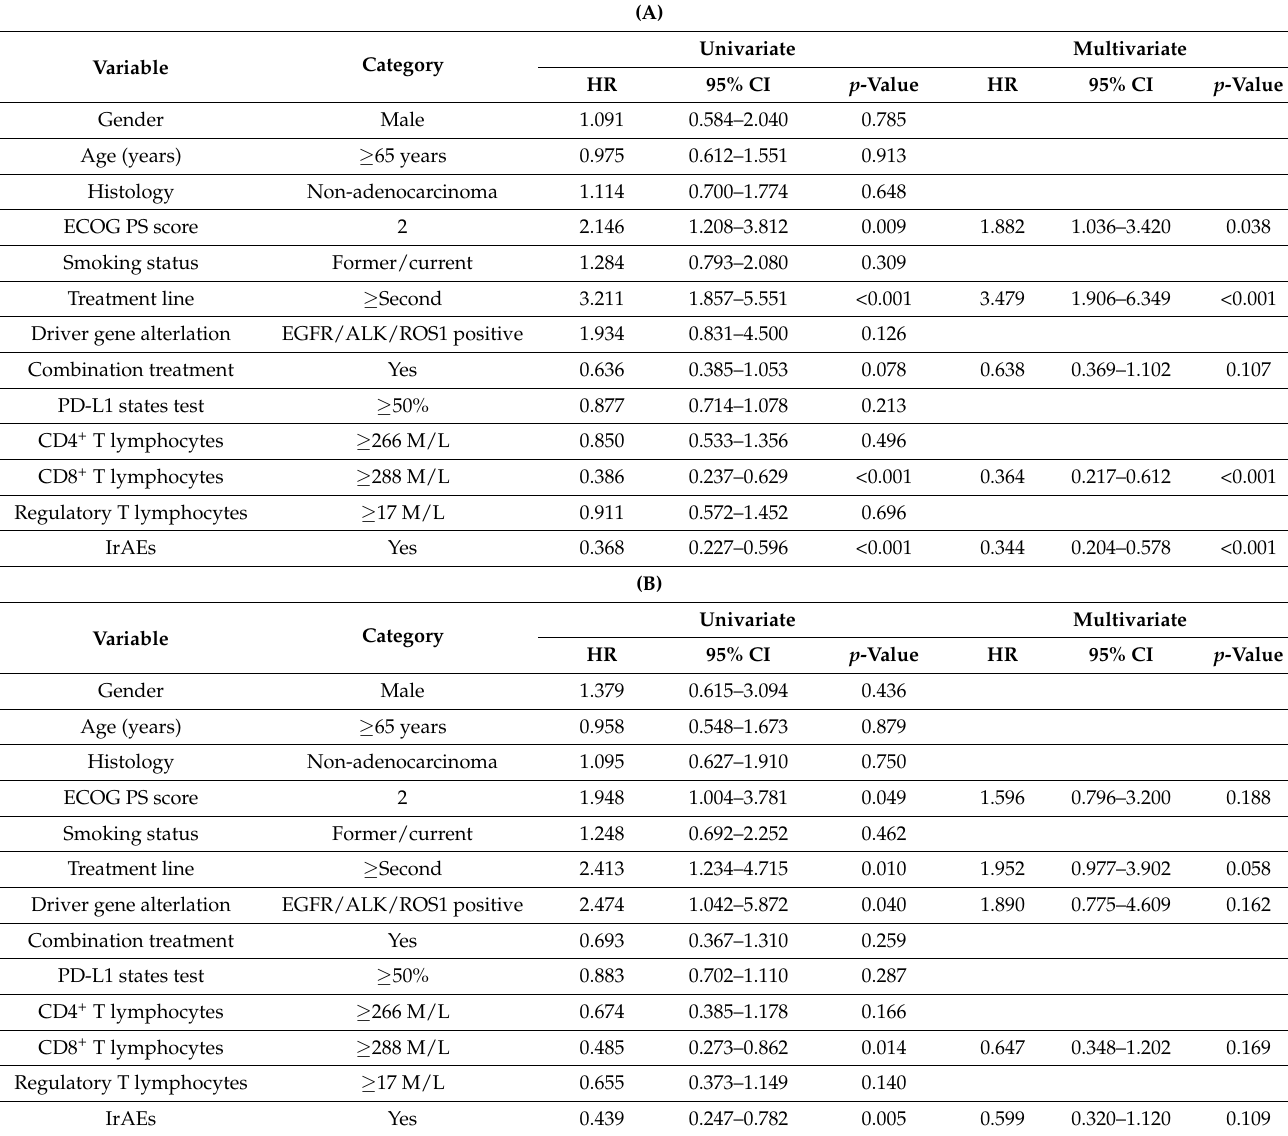
Table 4. (A) Cox analysis of influencing factors for progression-free survival of 109 lung cancer patients treated with immunotherapy. (B) Cox analysis of influencing factors for overall survival of 109 lung cancer patients treated with